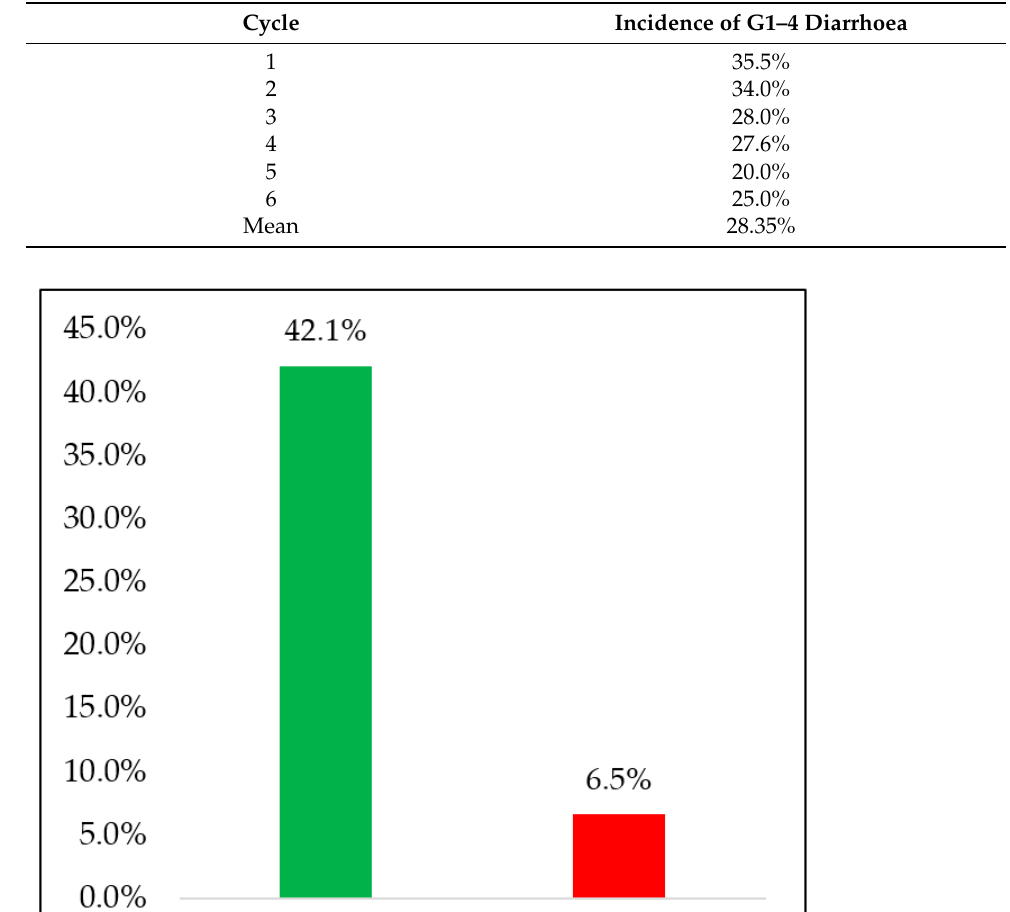
Table 2. Total incidence of grade 1–4 diarrhoea out of the total population evaluated.